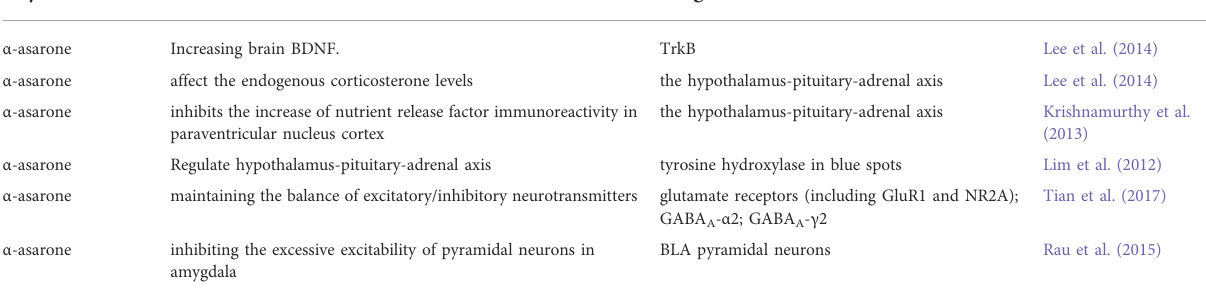
TABLE 7 The targets and mechanisms of VOA in